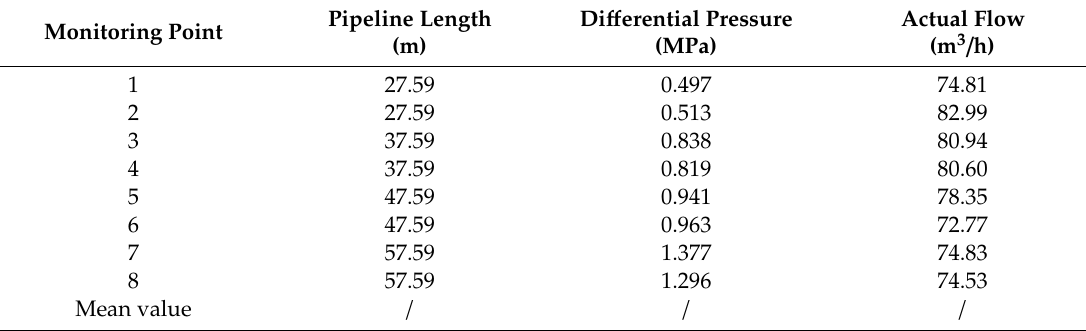
Table 4. Monitoring results of dihydrate-hemihydrate phosphogypsum filling slurry pressure and